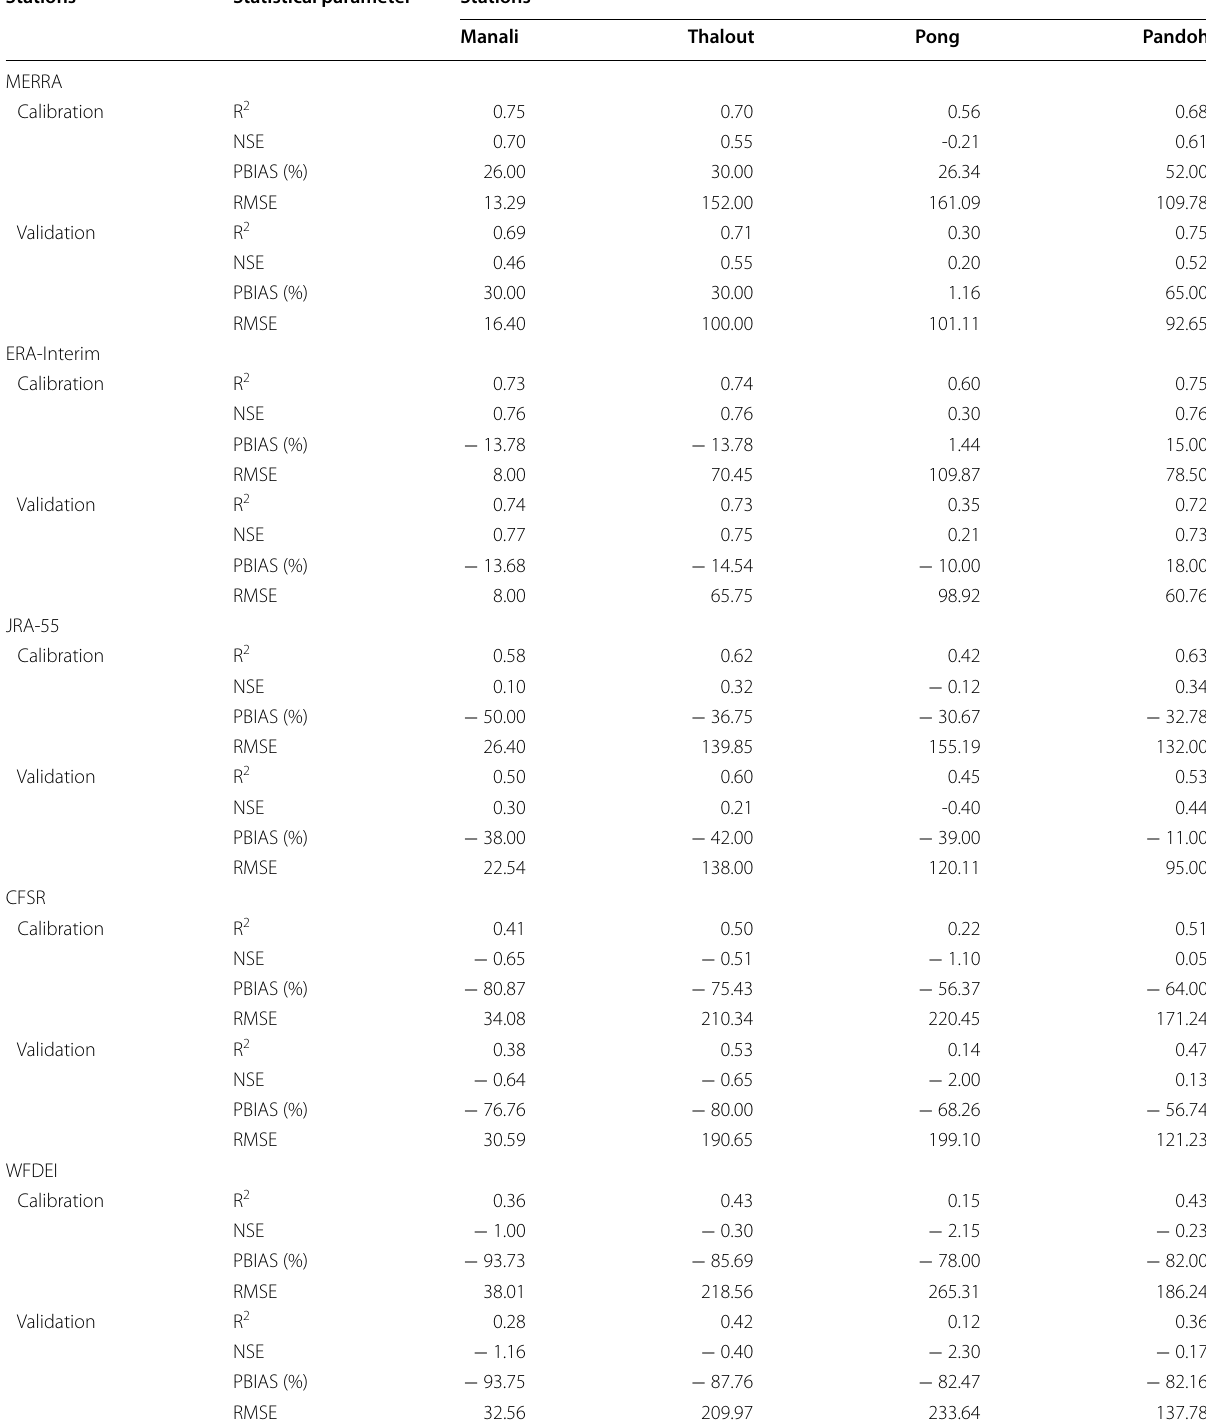
Table 3 Statistical indicators during calibration and validation at monthly scale (1990–2009)